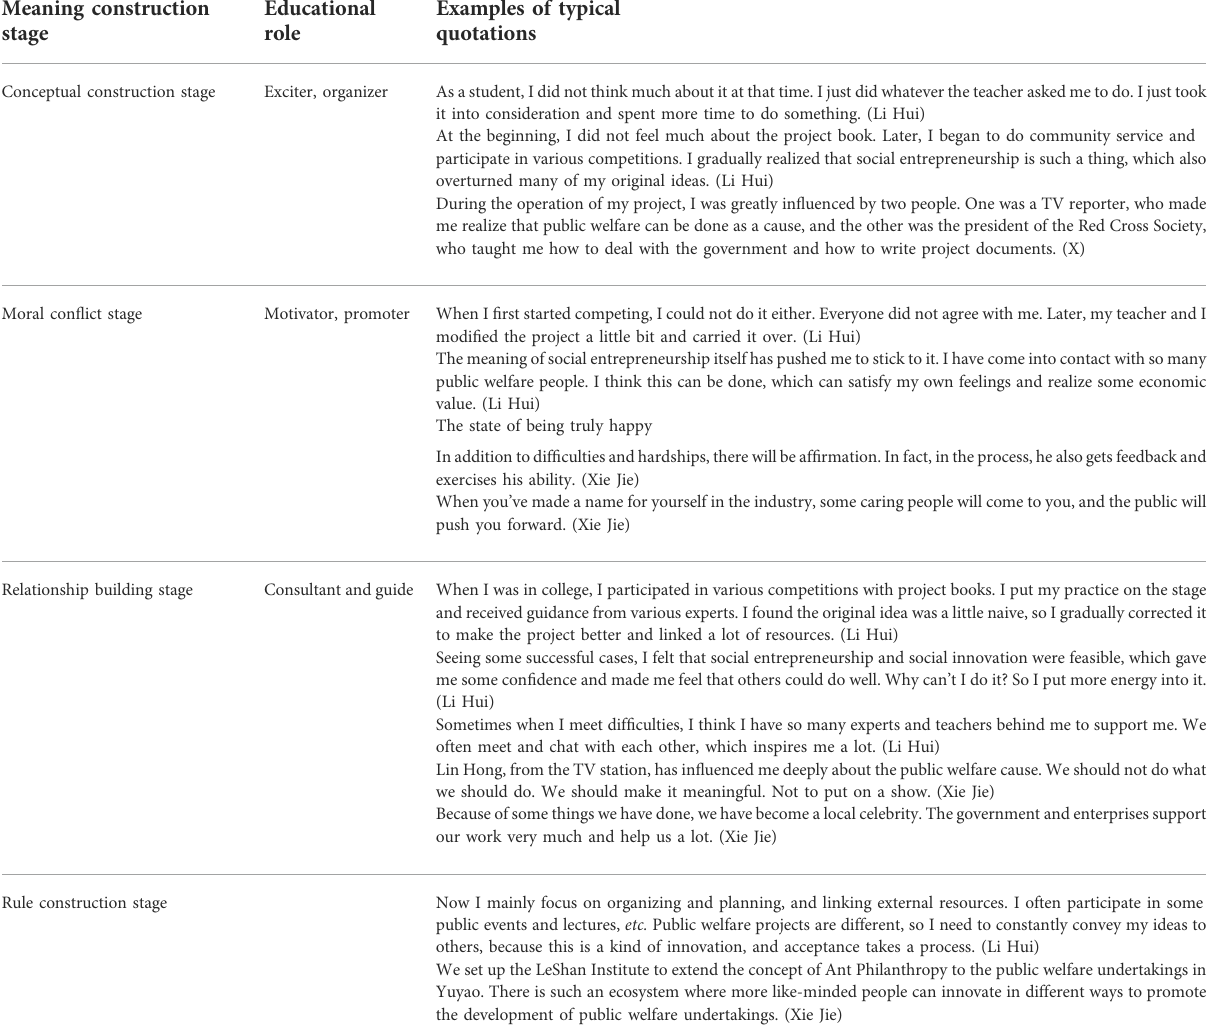
TABLE 7 Examples of typical statements regarding the roles of public welfare entrepreneurship education in different stages of meaning construction. Meaning construction